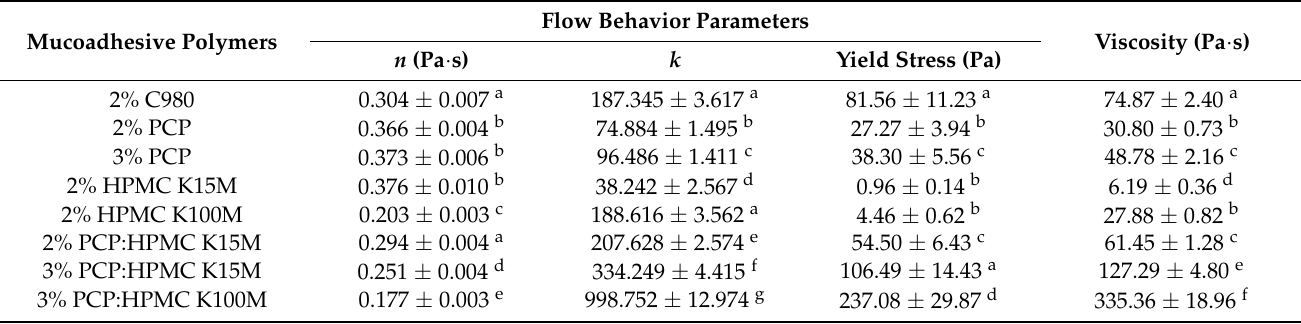
Table 2. Effects of mucoadhesive polymers on the rheological exponent ( n ), consistency ( k ), yield value, and low shear viscosity of C. comosa mucoadhesive gels (37 ◦